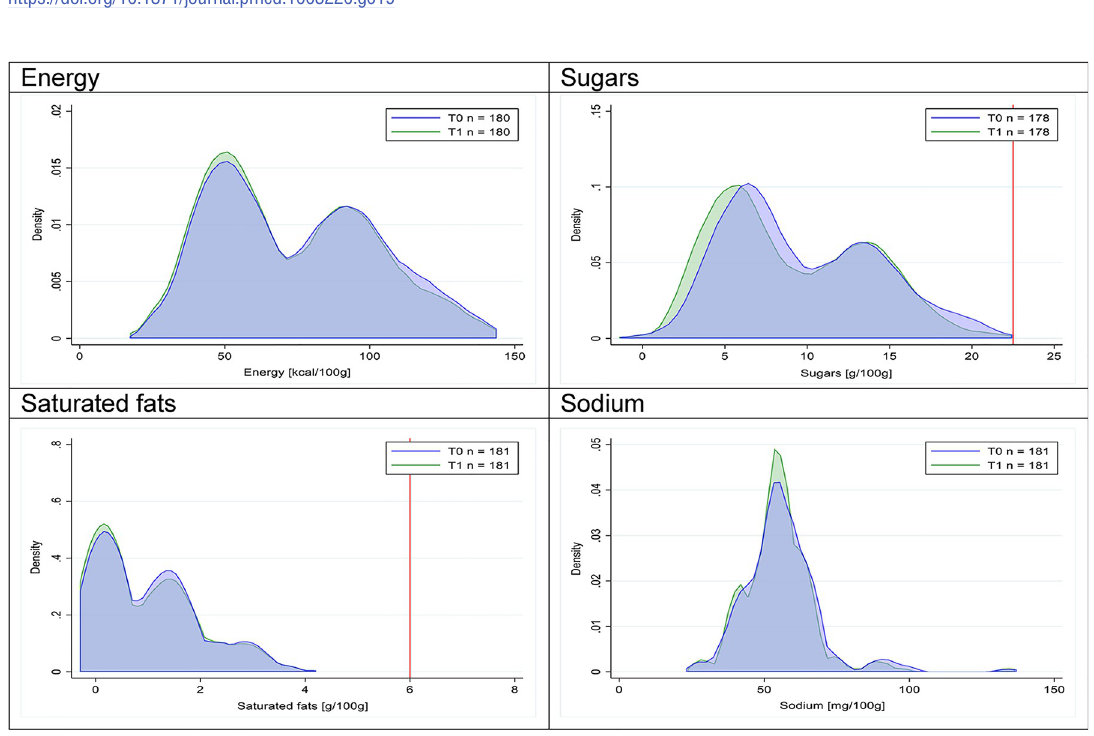
Fig 20. Density curves for the amount of energy and nutrients of concern in yogurts, longitudinal subsample. The blue line represents the distribution in T0 (preimplementation), the green line represents the distribution in T1 (postimplementation), and the red line represents the cutoff for the amount of energy or nutrients of